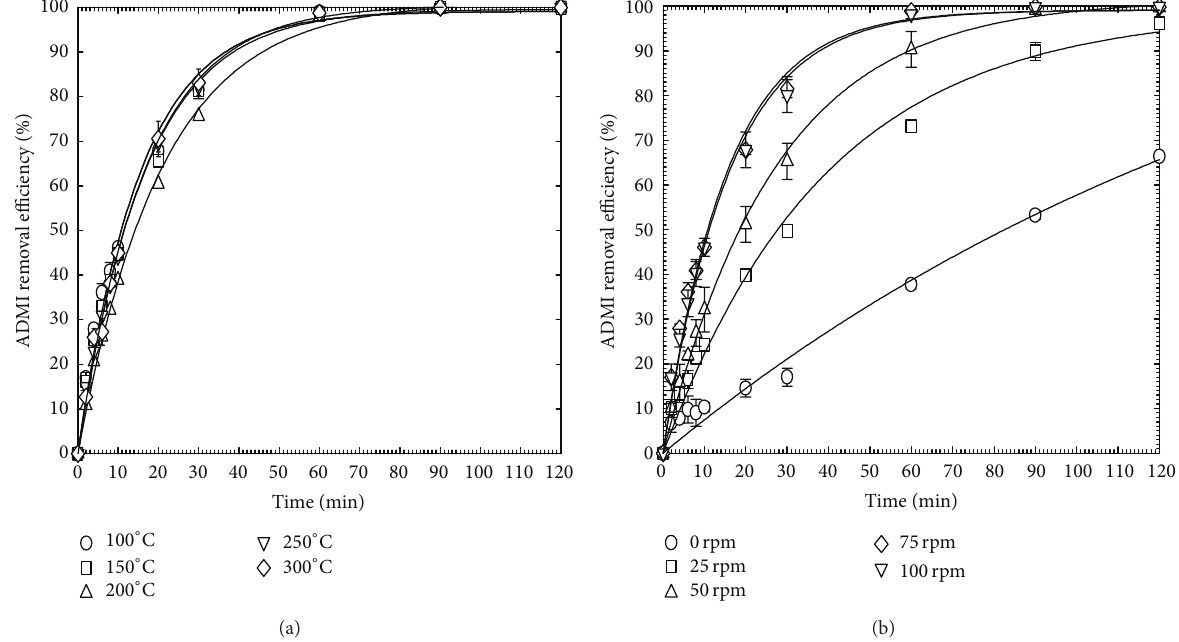
Figure 3: Effect of (a)preparation temperature and (b)mixing speed. Theconditions were initial dyeconcentration of 50mgL −1 , ZnOloading of 60 gm −2 , light intensity of 2.1mWcm −2 , and reaction time during